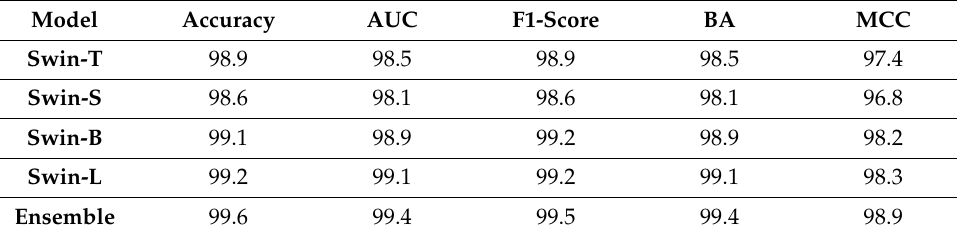
Table 2. Performance metric values on the test set for the two-class classification (benign vs. malig- nant) of BC by considering images from all zoom factors. AUC : area under the receiver operating characteristic curve, BA : balanced accuracy, MCC: Matthew’s correlation coefficient, T: tiny, S: small, B: base, L: